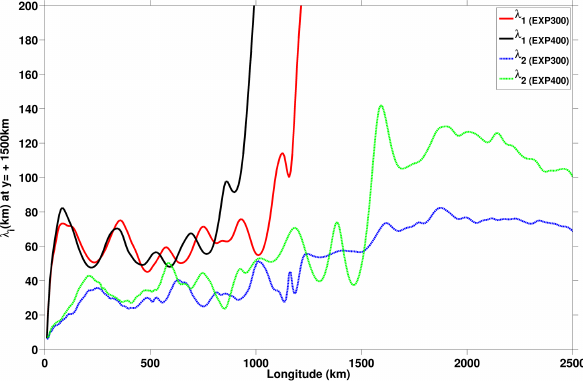
Figure 4. Zoom of zonal profiles of the Taylor scale λ 1 (solid lines, Eq. 11) and the viscous dissipation length-scale λ 2 (dashed lines, Eq. 12) at latitude y = + 1500km for the most turbulent experi- ments EXP300 and